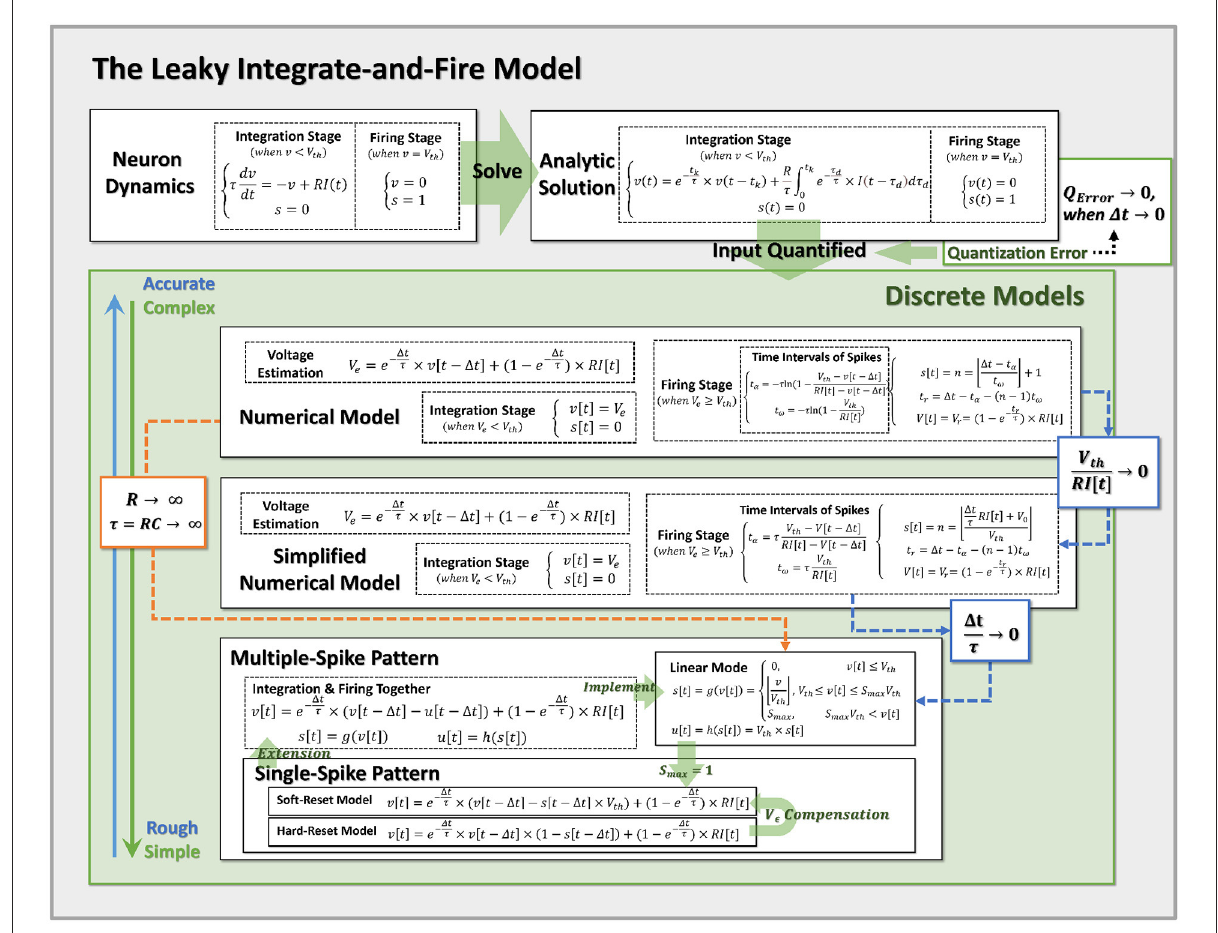
FIGURE3 Pipeline for discretization from neuron dynamics to discrete models of varying complexity. By incorporating the prior assumptions, we infer the neural dynamics from top to bottom and derive the more reduced discrete models with the approximation conditions. Notably, Hard-Reset Model and Soft-Reset Model are positioned at the bottom of the discrete model, implying they are the most basic and simplest